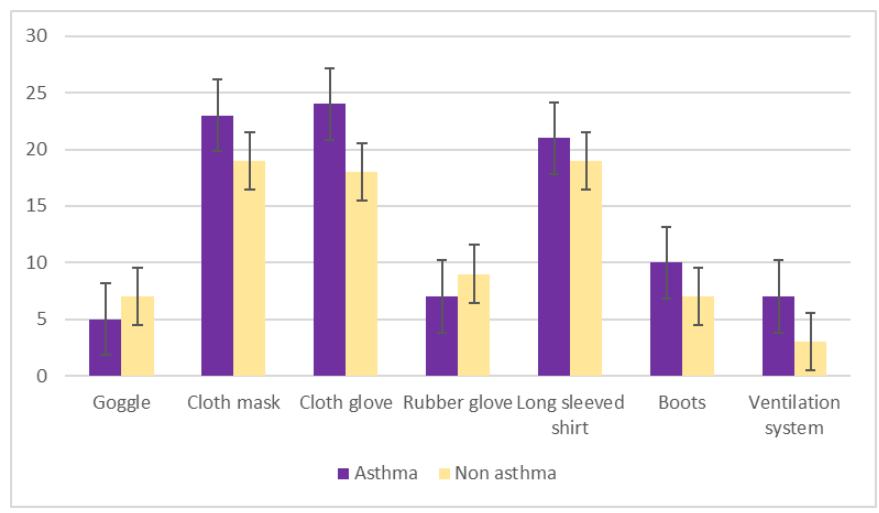
Figure 4. Types of electronic waste items handled by study participants.